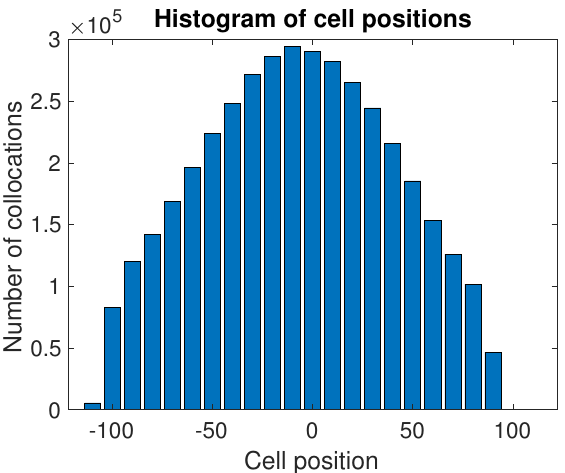
Figure 7. Histogram of the cell positions for the matchups used in this